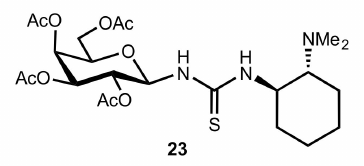
Figure 3. Galactose-based organocatalyst 23 . The three organocatalysts (10 mol%) were able to promote enantioselective addition at very low temperature, but the best results were found with 18 , which afforded excellent stereochemical outcomes, with up to 96% ee (Scheme 6). However, the reaction did not proceed neither for nitro-substituted aryl nitroolefin nor for the alkyl derivative. An application of the bifunctional pyrrolidine-based glucosyl thioureas 25 and 26 (Scheme 7) in a highly stereoselective Michael addition of cyclohexanone to various ni- troolefins was reported by Zhou’s group